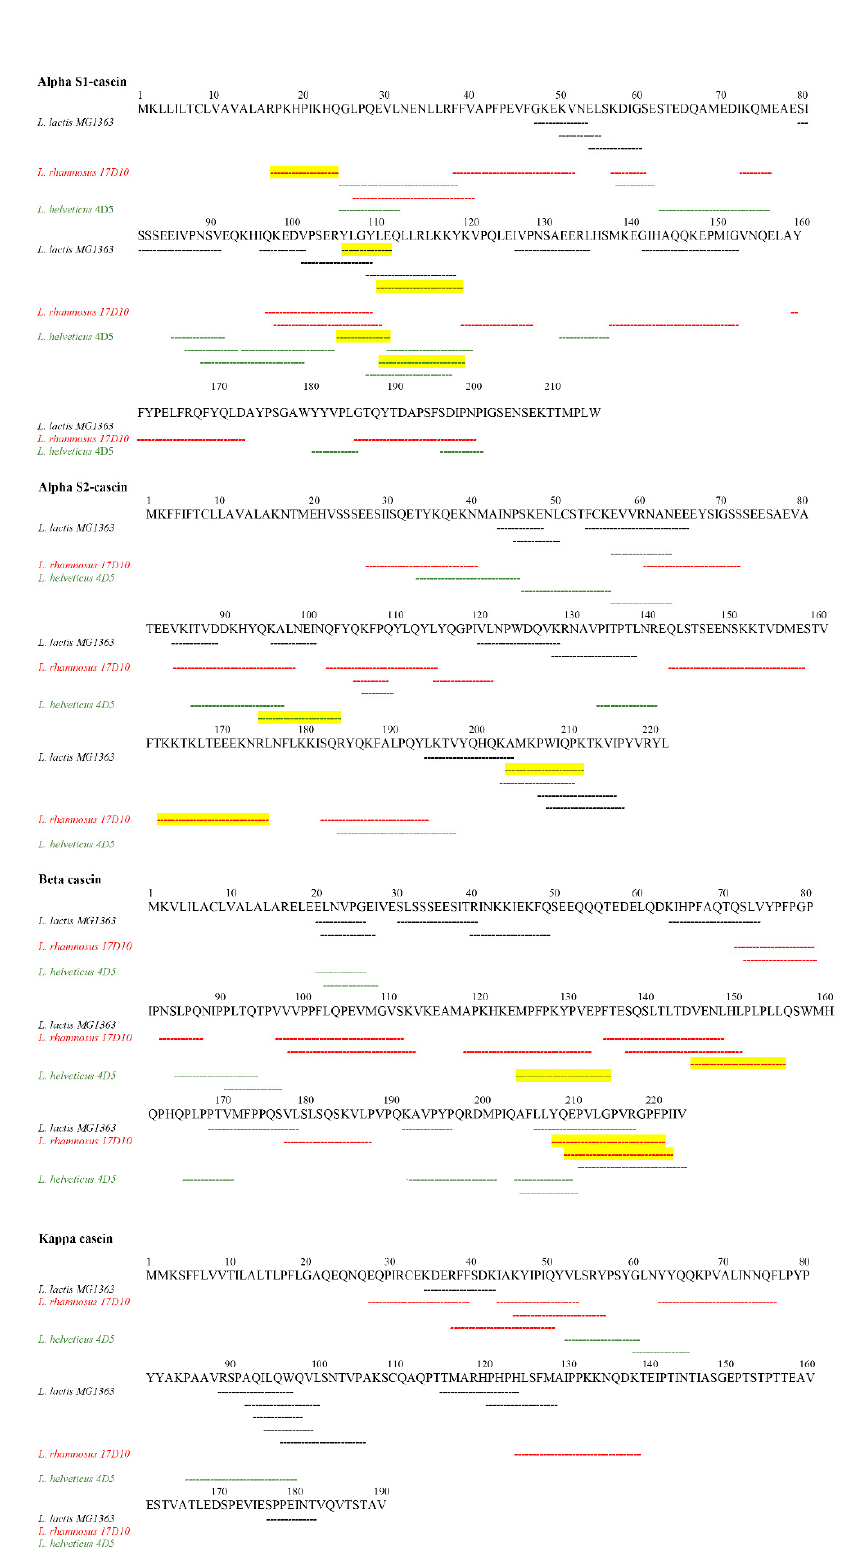
Figure 4. Peptide coverage of the four caseins digested by L. lactis MG1363 (black), L. rhamnosus 17D10 (red) and L. helveticus 4D5 (green). Peptides with established bioactivity are underlined in yellow.